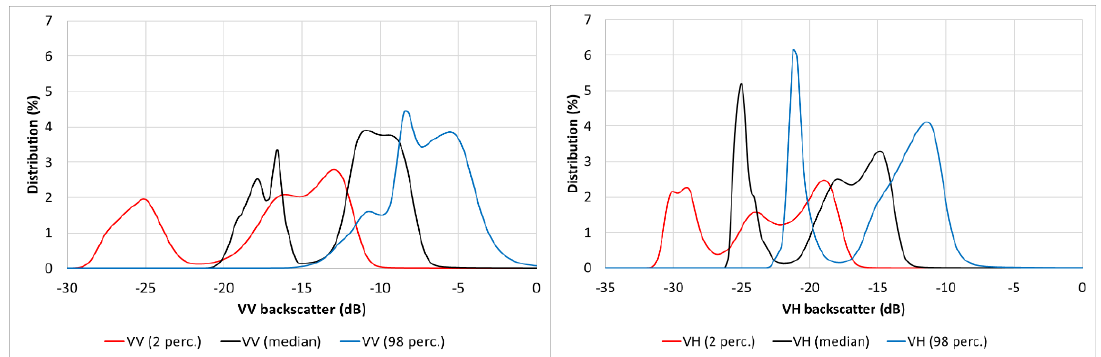
Figure 5. VV ( left ) and VH ( right ) backscatter histograms of the second, 50th, and 98th percentile backscatter images of a 1 year time series of Sentinel-1 from a Norwegian coastal area.